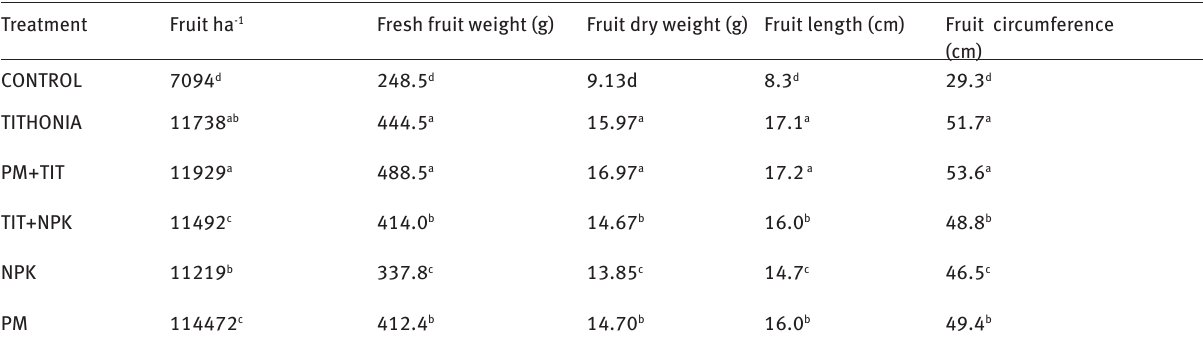
Table 4: Mean effect of application of organic and NPK fertilizer on yield of summer squash in 2015 and 2016 cropping seasons